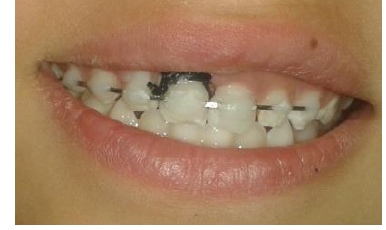
Figure 3: Replacement of the lost left central incisor crown with a fabricated replica.